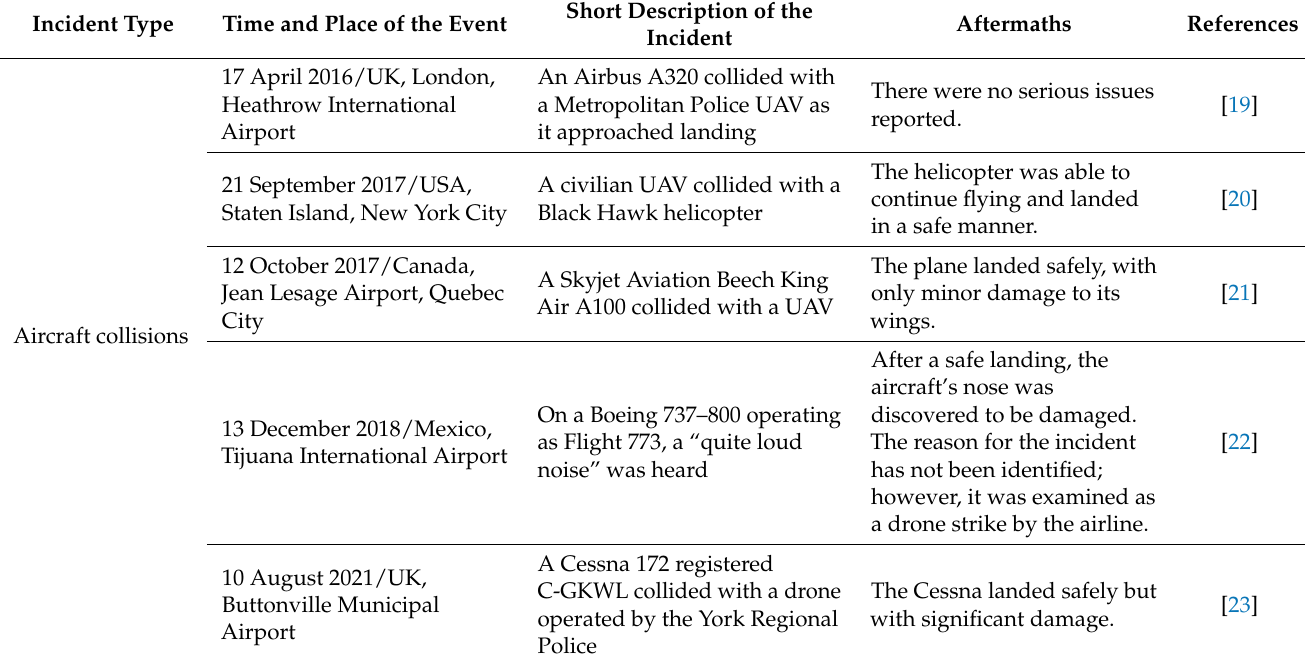
Table 1. List of the recent UAV-related